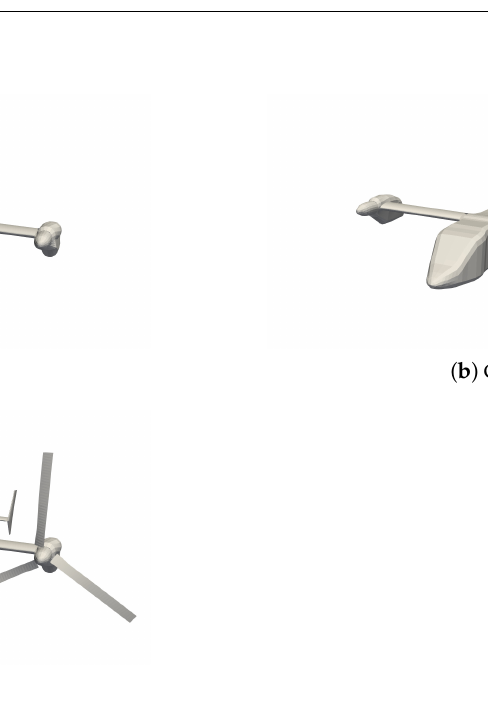
Figure 14. Geometry of aircraft configurations tested for roll maneuver coupled simulations.